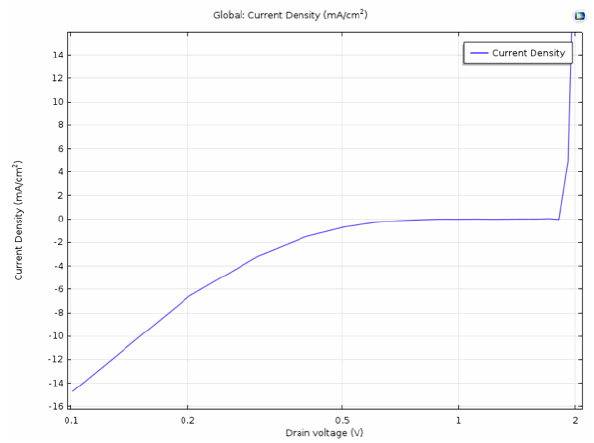
Figure 5. Current density versus voltage characteristics of a-Si solar cell before adding sidewall passivation.